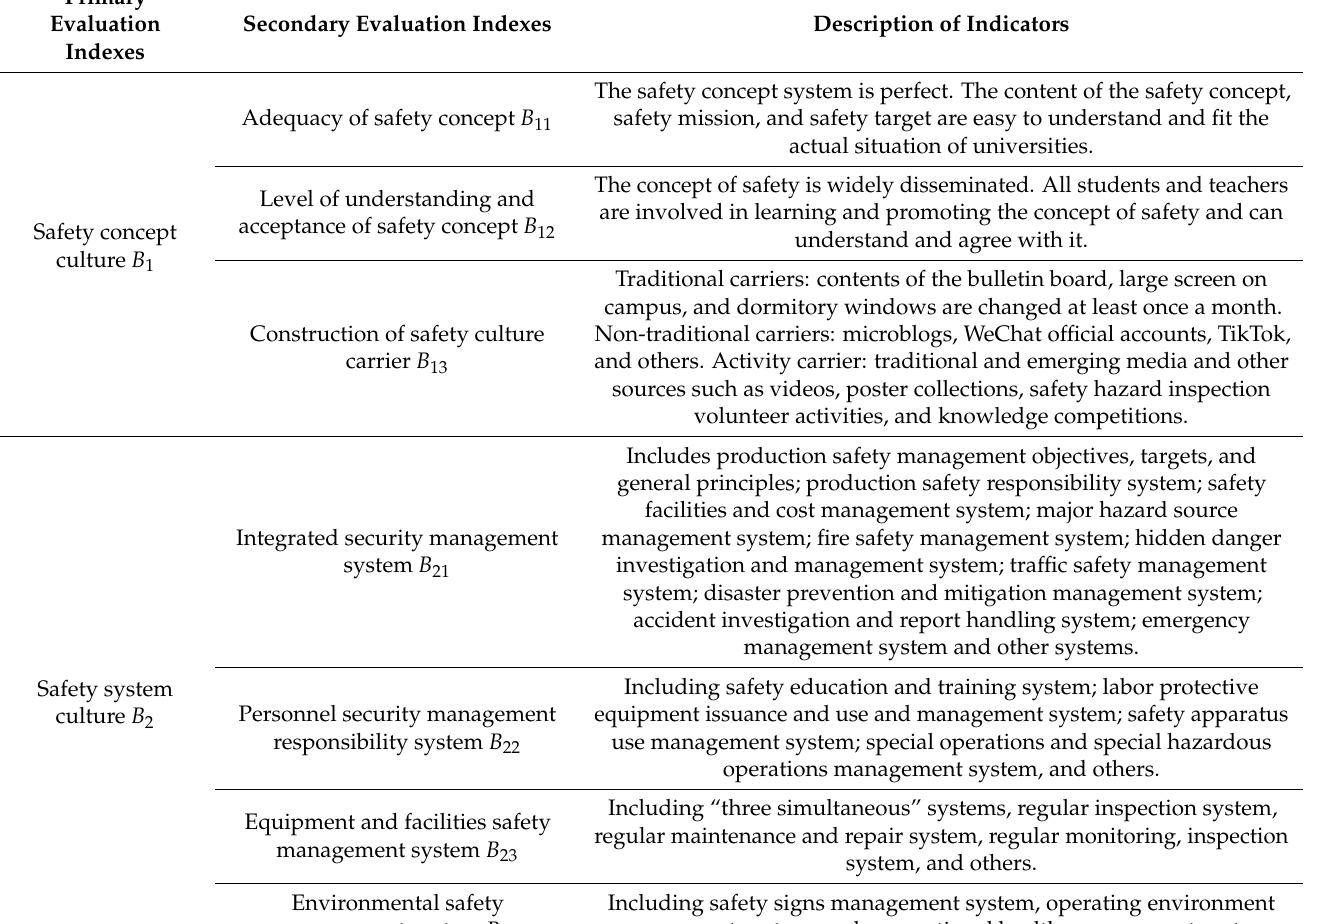
Table A1. Meaning and explanation of evaluation indicators of the safety culture construction level in colleges and